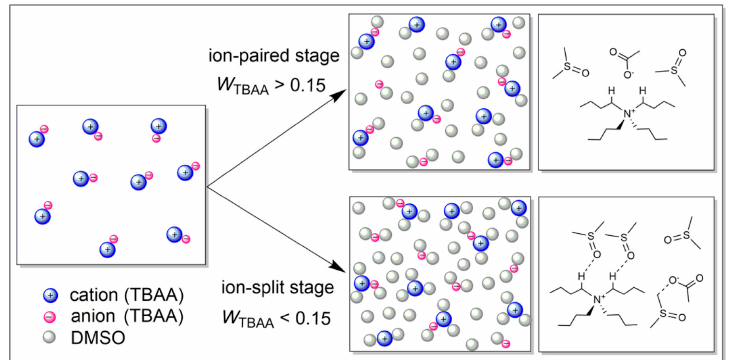
Figure 4. Schematic representation of the association of cellulose with the ions of TBAAcO as a function of the mass ratio W TBAAcO of the QAE with DMSO; reprinted with permission from [85], Copyright (2016) American Chemical Society.